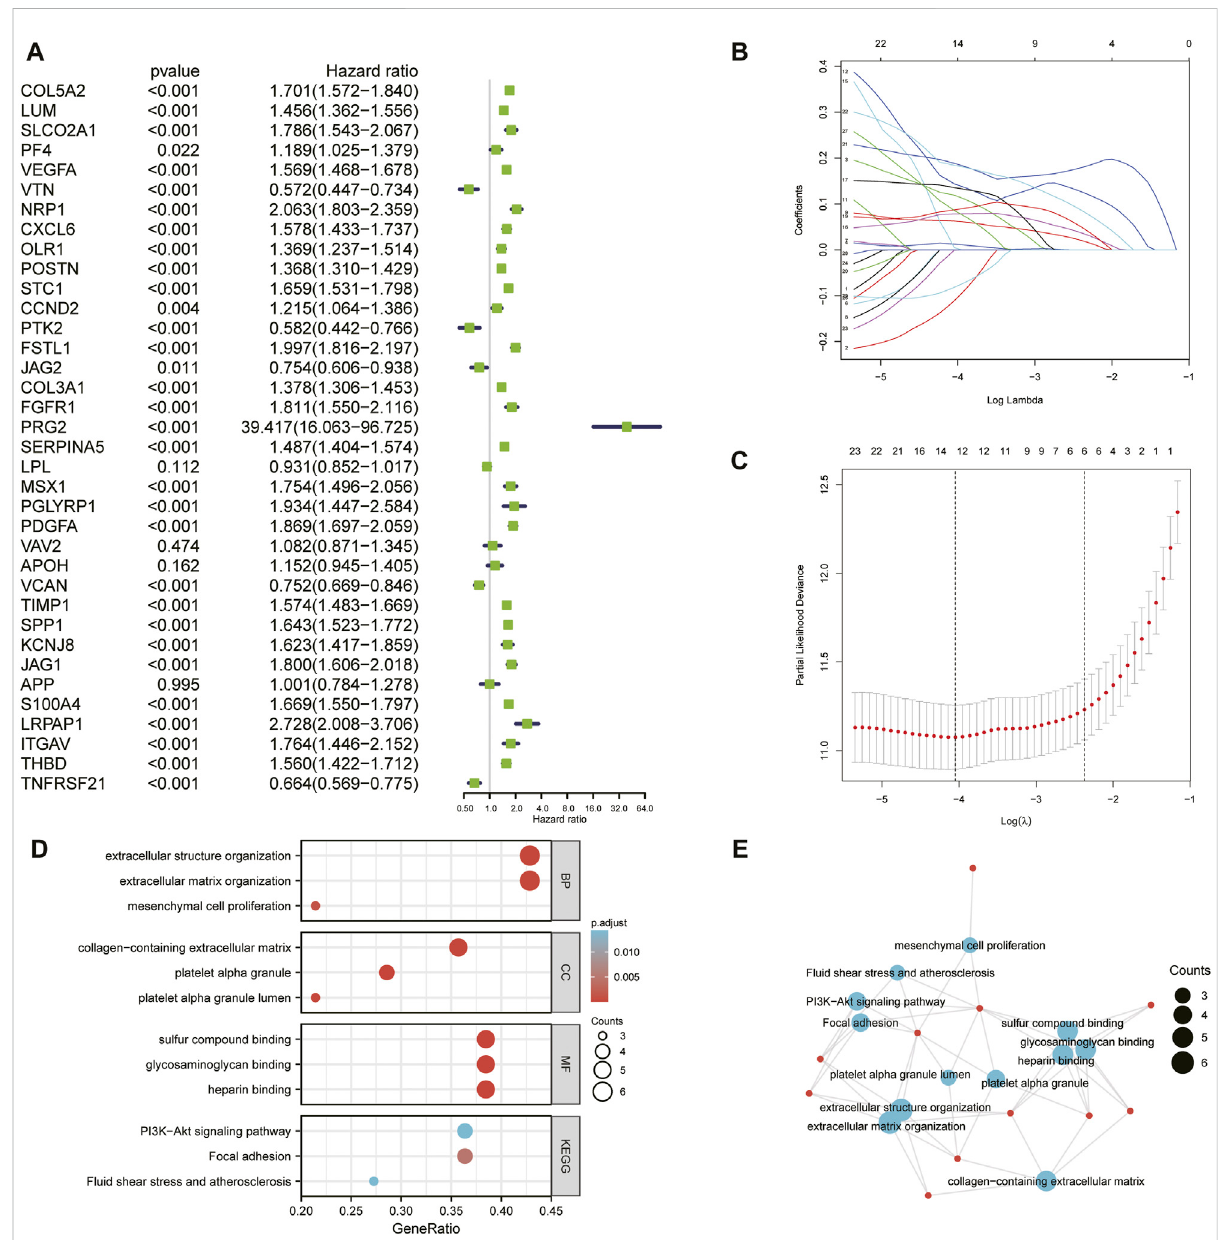
FIGURE 3 (A) Univariate Cox regression analysis of the 36 ARGs in the TCGA cohort. (B) LASSO coef fi cient pro fi les of the common genes. (C) Cross- validationfortuningparameterscreeningintheLASSOregressionmodel. (D) GOandKEGGenrichmentanalysisacrossthe14genes. (E) Functional- enrichment map of pathways of the 14